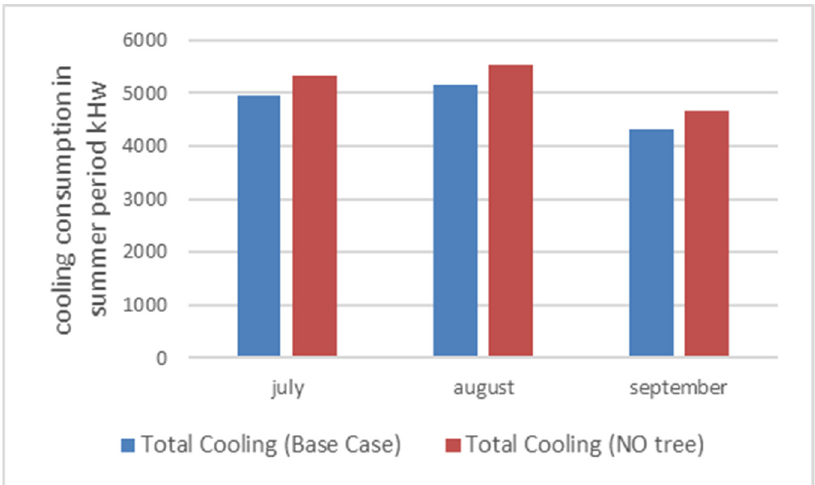
Figure 14. Cooling consumption in the summer period for Case 2 with modifying the weather file.